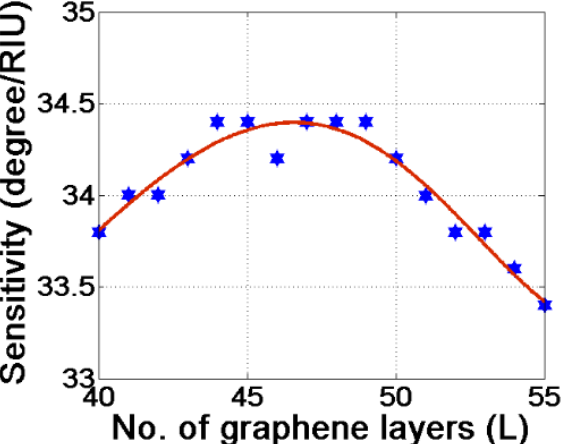
Figure 11. Sensitivity variation with no. of graphene layers for bio sensing probe (without silicon) with 50 nm of Au. Maximum sensitivity is calculated to be 33.75 degree/RIU. The star symbols are simulated data points, which are fitted with red line.